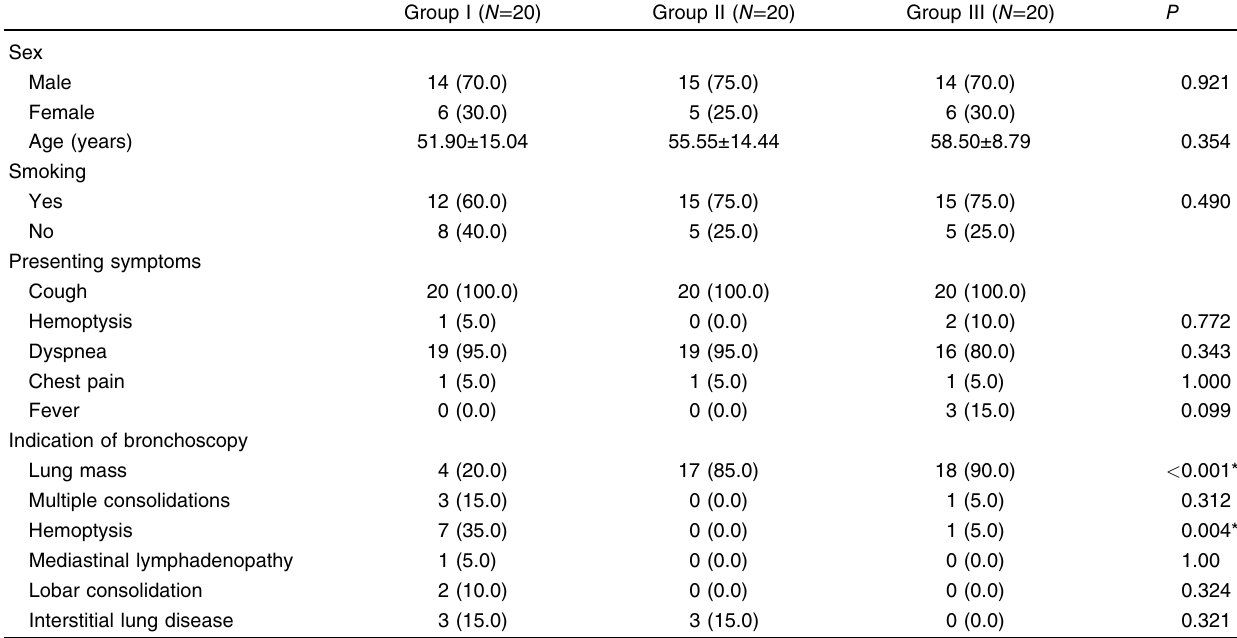
Table 1 Comparison between the three studied groups according to demographics, presenting symptoms and indication of